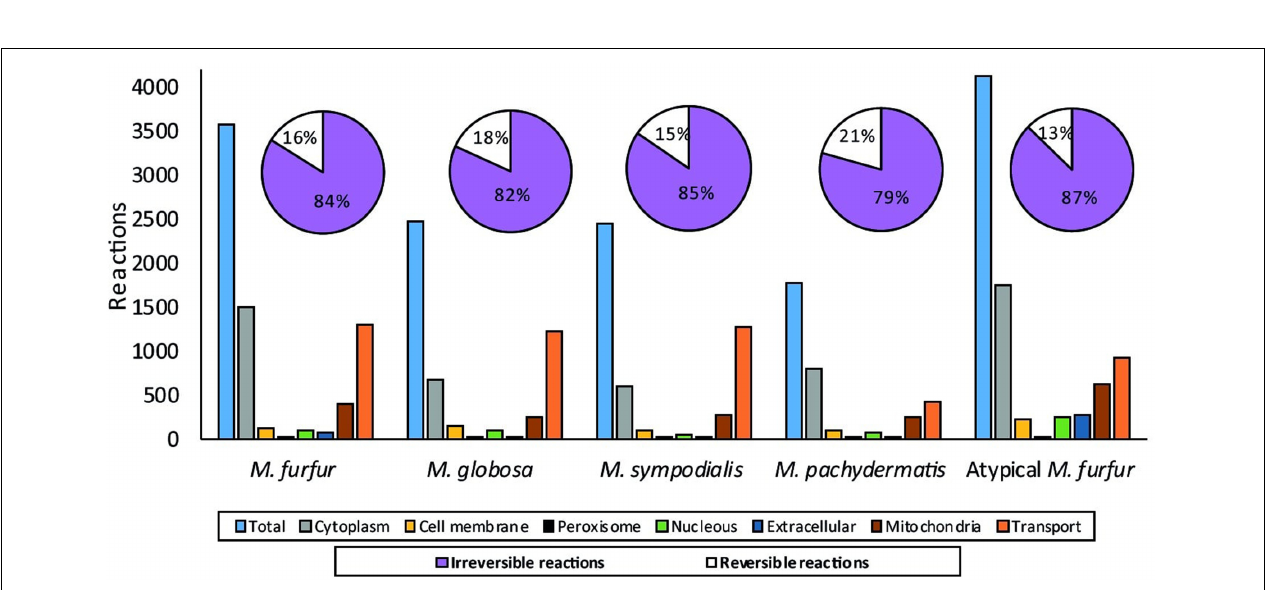
FIGURE 5 | Distribution of the reactions after compartmentalization with the subCELlular LOcalization predictor (CELLO) (Yu et al., 2004) and the percentage of reversible and irreversible reactions determined from the Gibbs free energy of the reactions calculated with the group contribution approach and from the literature.